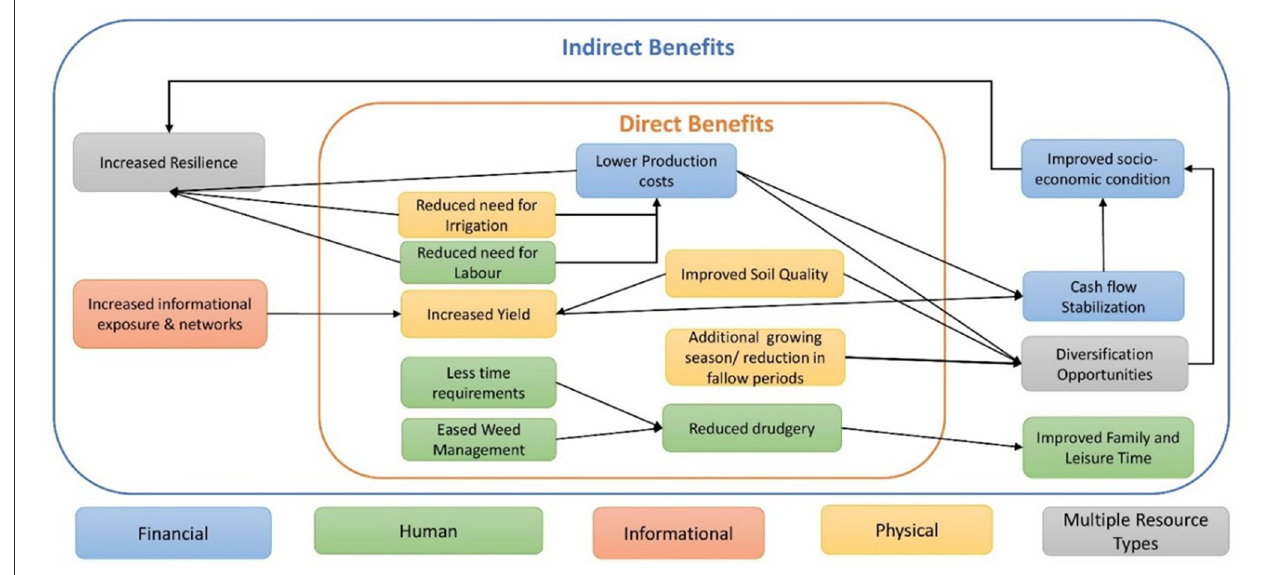
FIGURE 3 | The direct and indirect benefits of CASI use as identified by